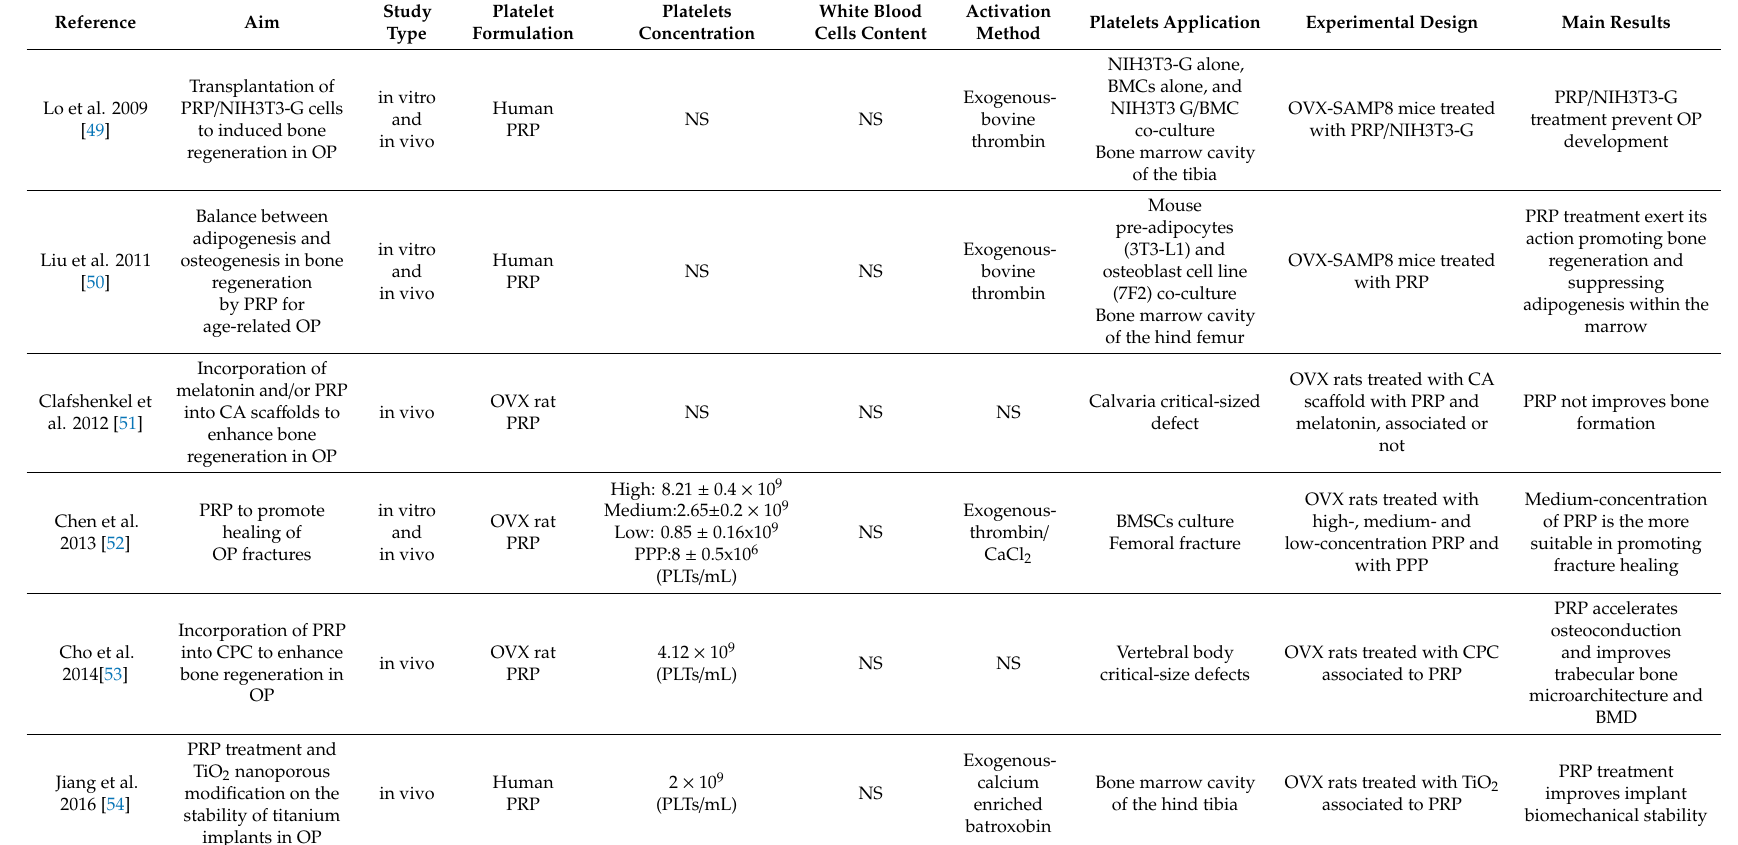
Table 3. Preclinical studies on PLT